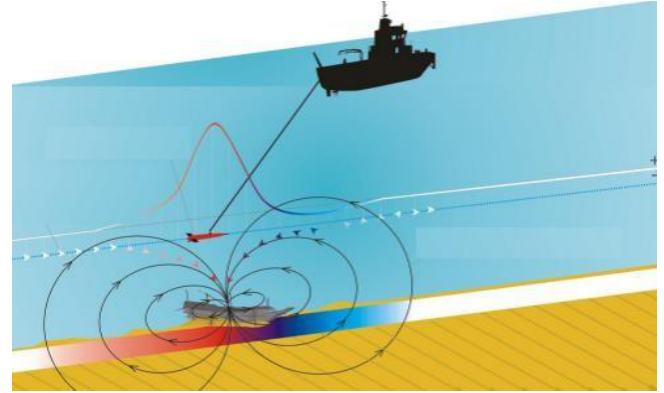
Figure 9. System of stern towing of the magnetometry equipment.